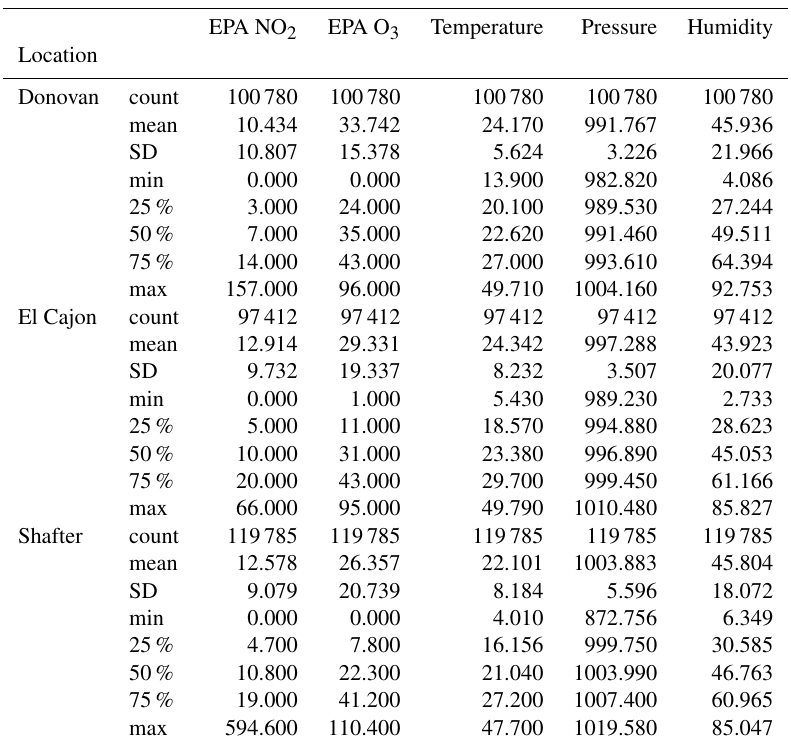
Table B1. Summary of data set grouped by